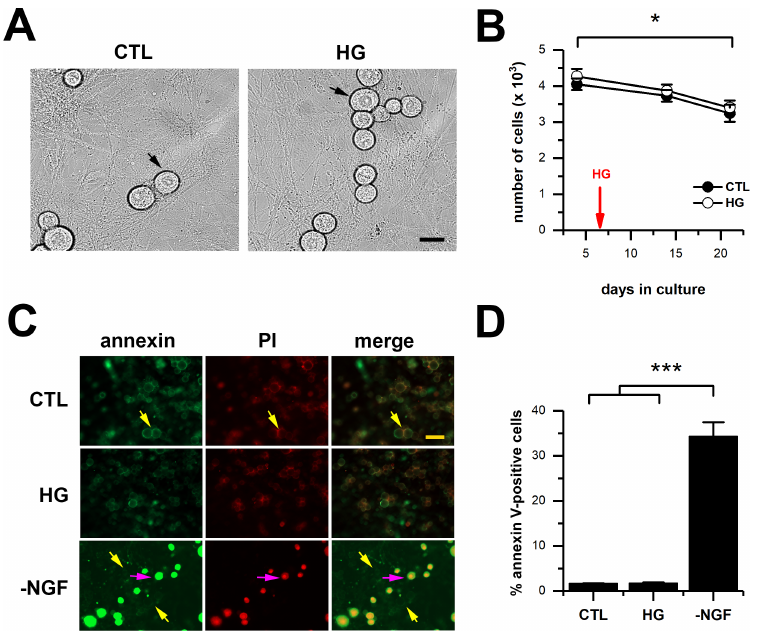
Fig 4. DRG neuronal counts for cultures from WT mice, maintained in either control (CTL) or high glucose (HG). A, representative phase-contrast images of neurons at 21 days after culturing, maintained in CTL or HG (for 14 days), show healthy neurons with clear nuclei (arrows) and smooth membrane (40x magnification). B, bar graph summarizes the number of neurons per culture dish in CTL (n = 7) and HG (n = 7) at 4, 14 and 21 days after culturing. All cultures were generated in control levels of glucose and half of them where switched to high glucose levels at 7 days after culturing (red arrow). C, representative images for annexinV-FITC and propidium iodide (PI) fluorescence, in either CTL, HG, or in -NGF as positive control (20x magnification). Yellow arrows show representative examples of non-apoptotic cells, and purple arrows show an example of an apoptotic/necrotic cell. D, bar graph summarizes the percentage of annexinV-positive cells (n = 4, per condition), 1.6% for CTL, 1.7% for HG, and 34.3% for -NGF. All data are represented as mean ± SEM, means were compared by repeated measures one-way ANOVA followed by Tukey post-hoc test (B); and by one-way (non-parametric) ANOVA followed by Dunn’s post-hoc test (D). (cid:3) , p < 0.05. Scale bars represent 30 μ m (A) and 50 μ m (C).